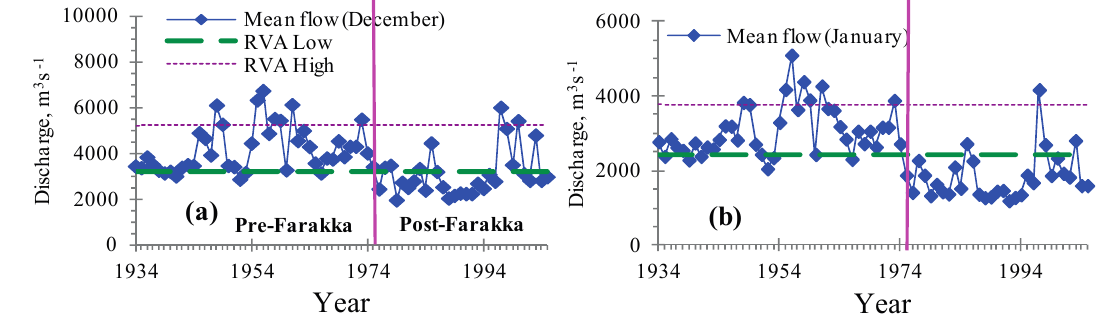
Figure 2. Monthly mean flow for the dry months of December ( a ), January ( b ), February ( c ), March ( d ), April ( e ) and May ( f ) in the pre- and post-Farakka period and a comparison with the threshold